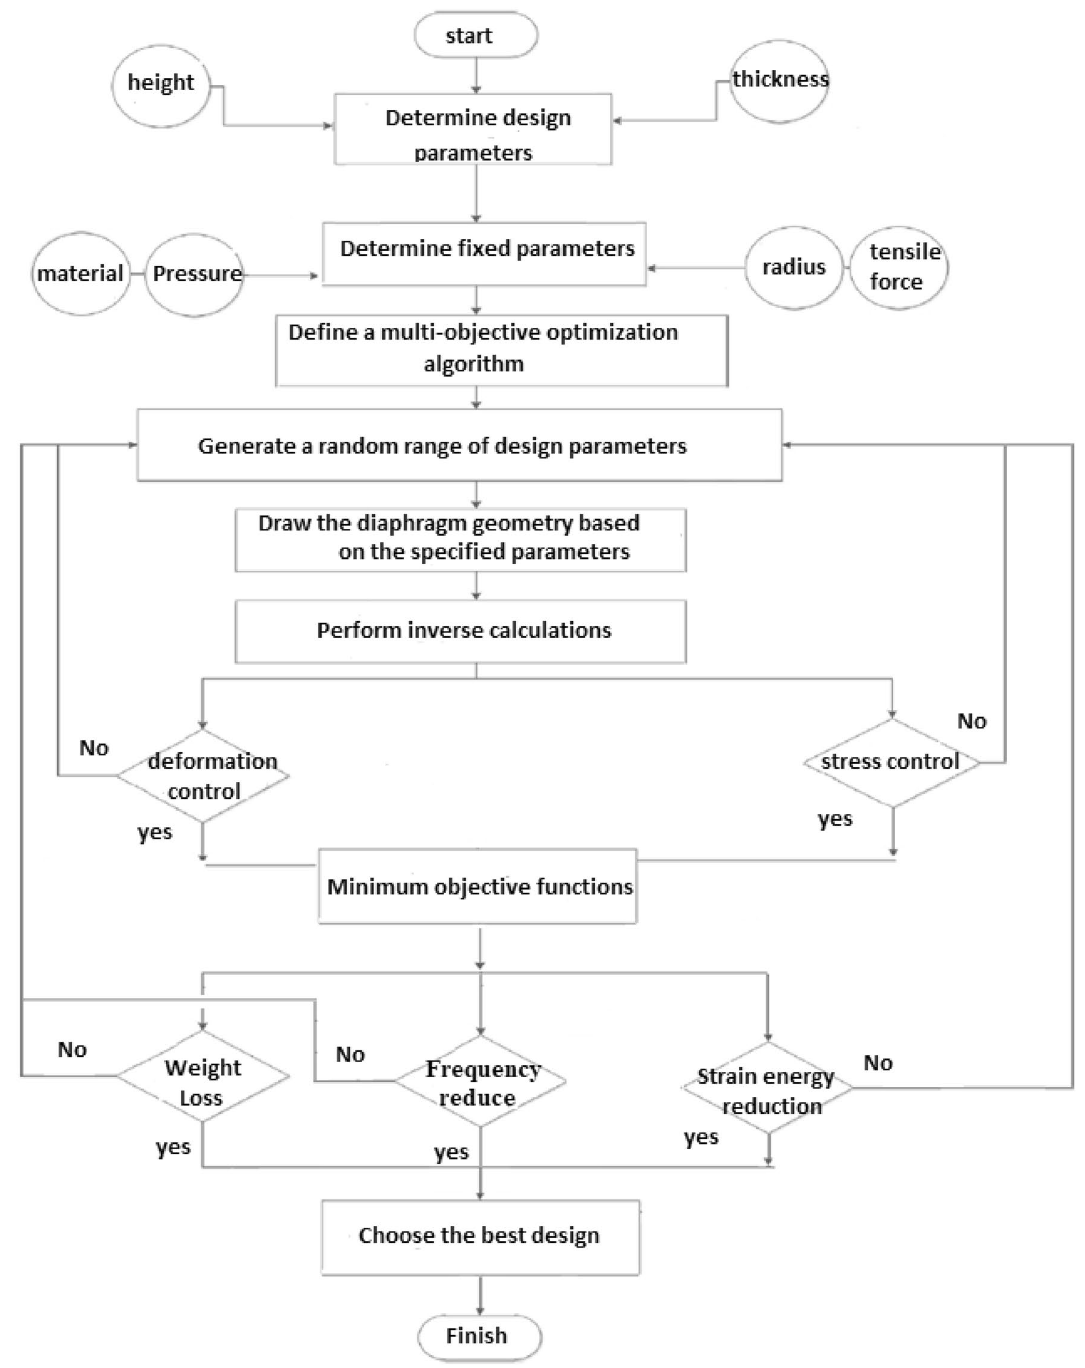
Fig. 30 Algorithm for optimal design of diaphragm